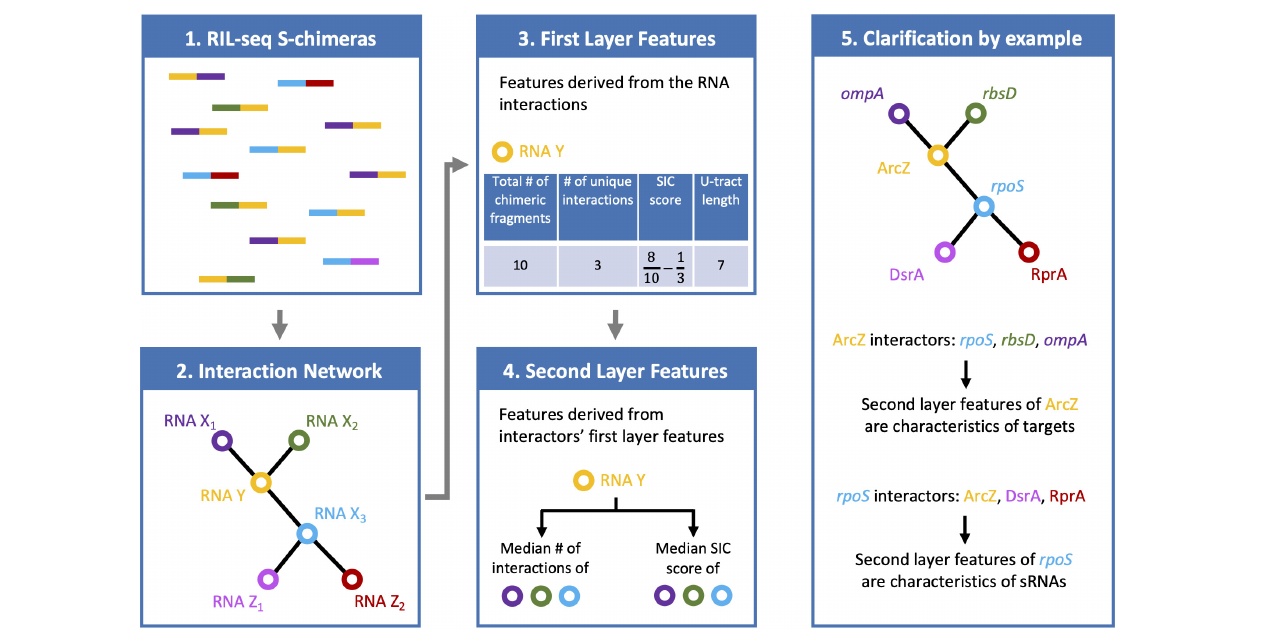
FIGURE 1 | Features characterizing a RNA in RIL-seq data. RIL-seq final data set includes chimeric fragments corresponding to S-chimeras (first box), determining RNA interacting pairs, which can be described as a RNA–RNA interaction network (second box). Each node in the network represents a RNA. Two nodes are connected by an edge if they were determined as interacting. For every RNA, first layer features were computed based on the chimeric fragments it was involved in (third box; U-tract length is not shown on the chimeric fragments). Finally, for each RNA, second layer features were computed based on the first layer features of its interacting partners (forth box). If the RNA is a sRNA, its first layer features are expected to be characteristic of a sRNA, namely, many chimeric fragments, many interactions, high fractions of chimeras in which it is second RNA (high SIC, Second-In-Chimera, score), long U-tract. The second layer features of the sRNA, which involve the first-layer features of its interactors, are expected to be characteristic of targets, namely, low number of interactions and low SIC scores (fifth